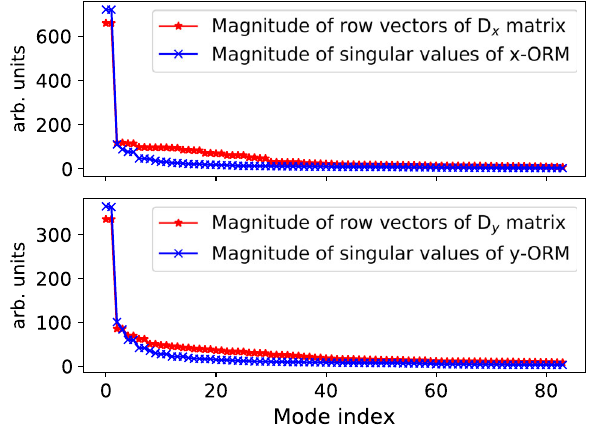
FIG. 8. Comparison of the SVD singular values with the magnitudes of the rows of matrix D defined in Eq. (25) for the SIS100 ORM in the x plane. The abscissa is the index of singular values of the matrix S as well as the index of rows of matrix D (after sorting in descending order of their magnitude).